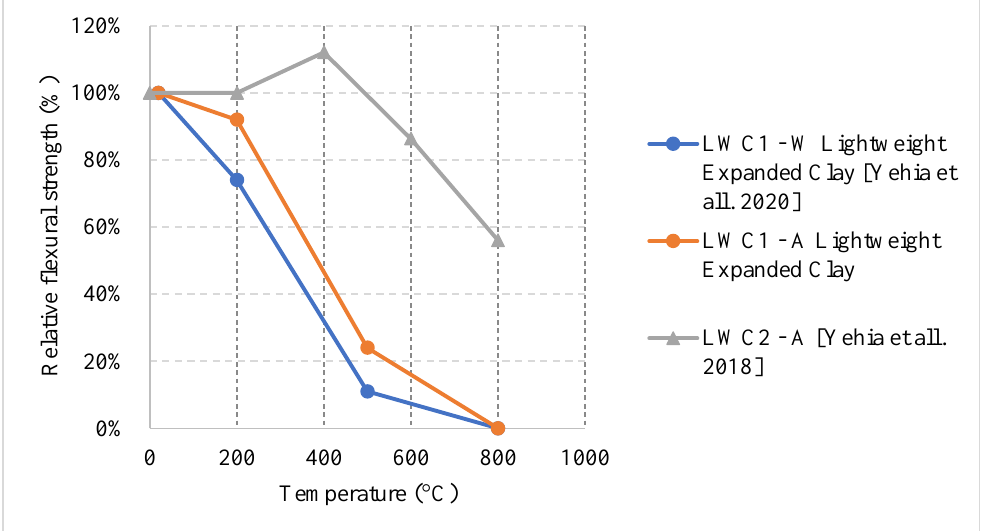
Figure 10. Relative flexural strength of naturally/water cooled LWC. W: Water cooled, A: Air cooled [64,65].